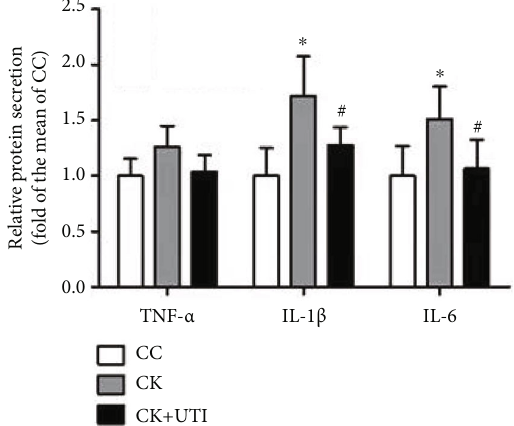
Figure 4: Repetitive KET-induced neuroin fl ammation can be alleviated by UTI. All result data were reported as mean ± SD ( n = 6 ). ∗ and # meant P < 0 : 05 and P < 0 : 01 ,